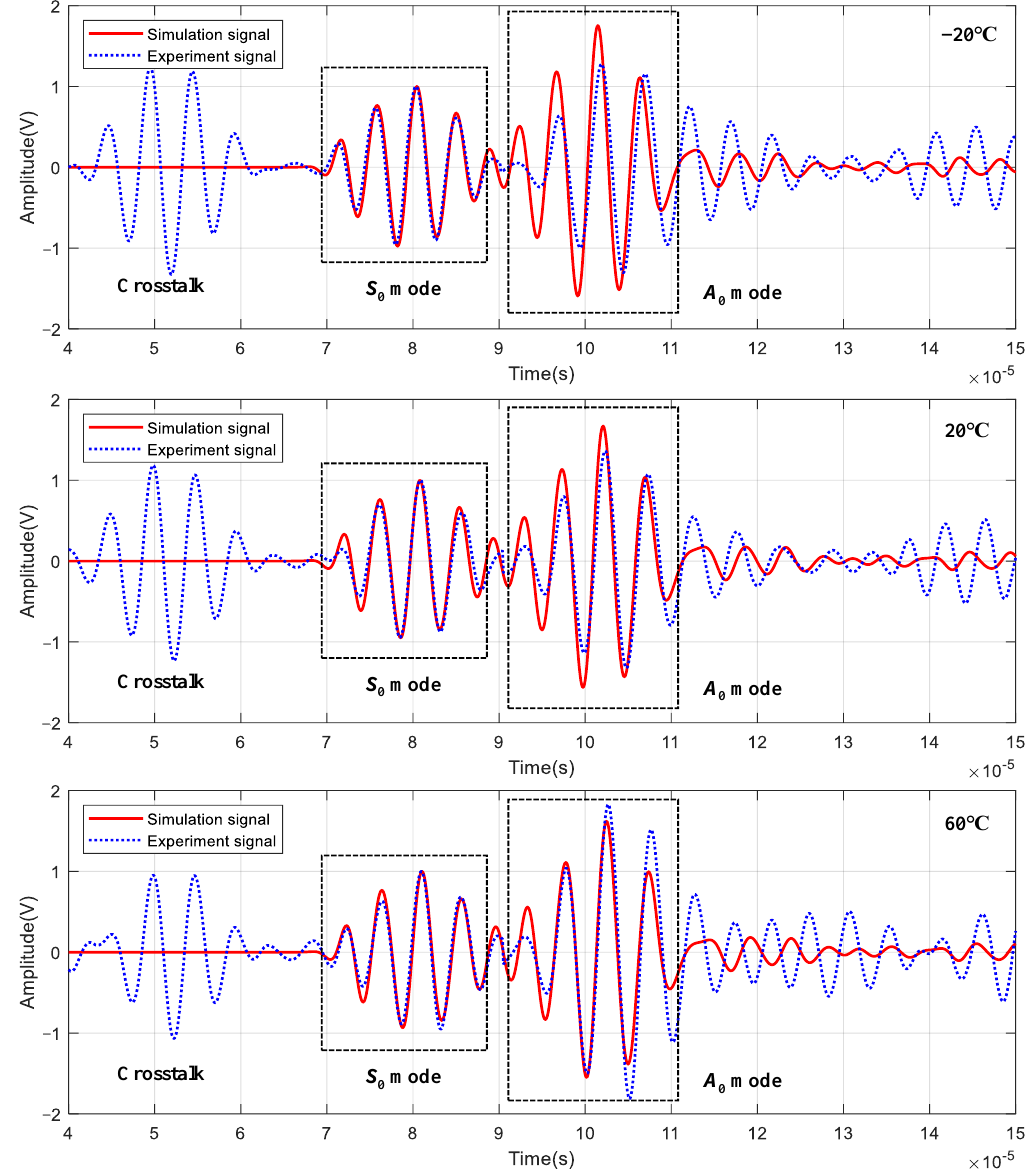
Figure 11. Comparison of LW signals between simulation and experiment.